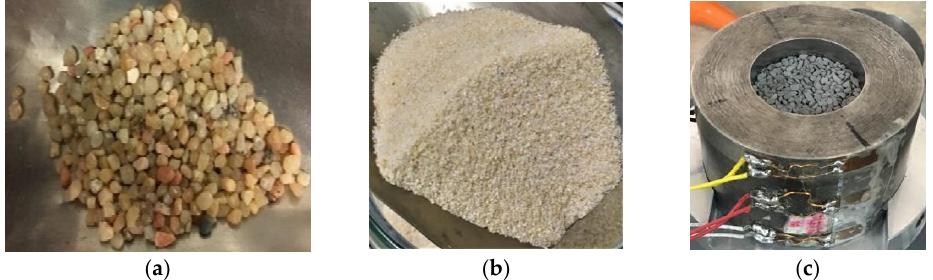
Table 1. Sand description: shape, mean diameter, and particle density.